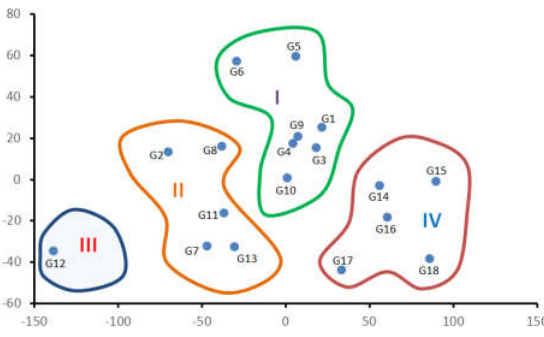
Fig. 2. Clusters of the different genotypes of kidney beans.